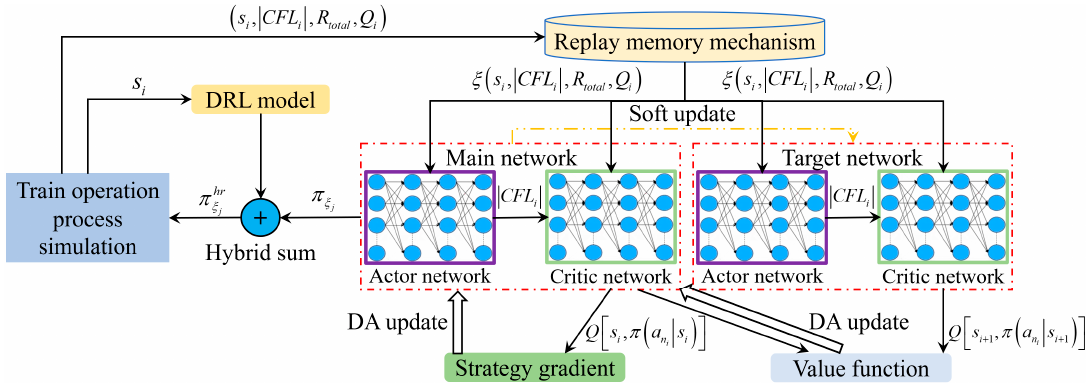
Figure 3. The DRLDA algorithm learning framework.